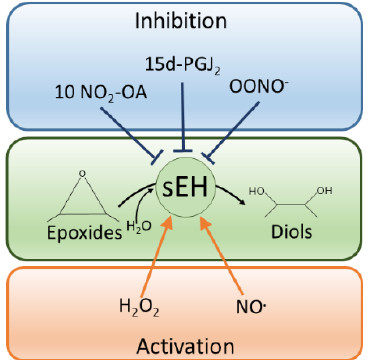
Figure 3. sEH activity is regulated by diverse redox mechanisms. Different reactive oxygen species or reactive nitrogen species can differentially modify sEH to alter its activity. For example, the lipid electrophiles 10-NO 2 -OA and 15d-PGJ 2 as well as peroxynitrite inhibit the hydrolase, whereas hydrogen peroxide or NO stimulate it.